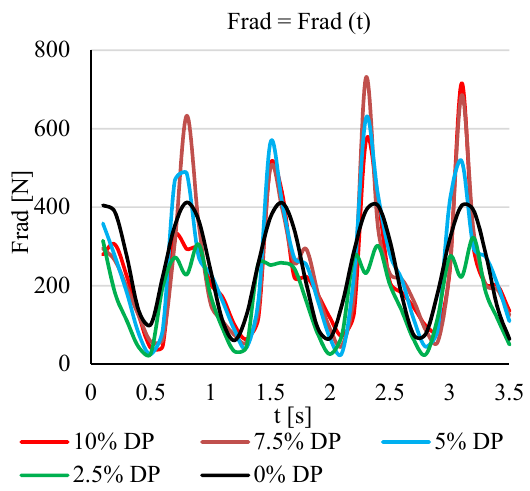
Fig. 3 Magnitude of radial forces acting on the rigid tube with different DP fraction